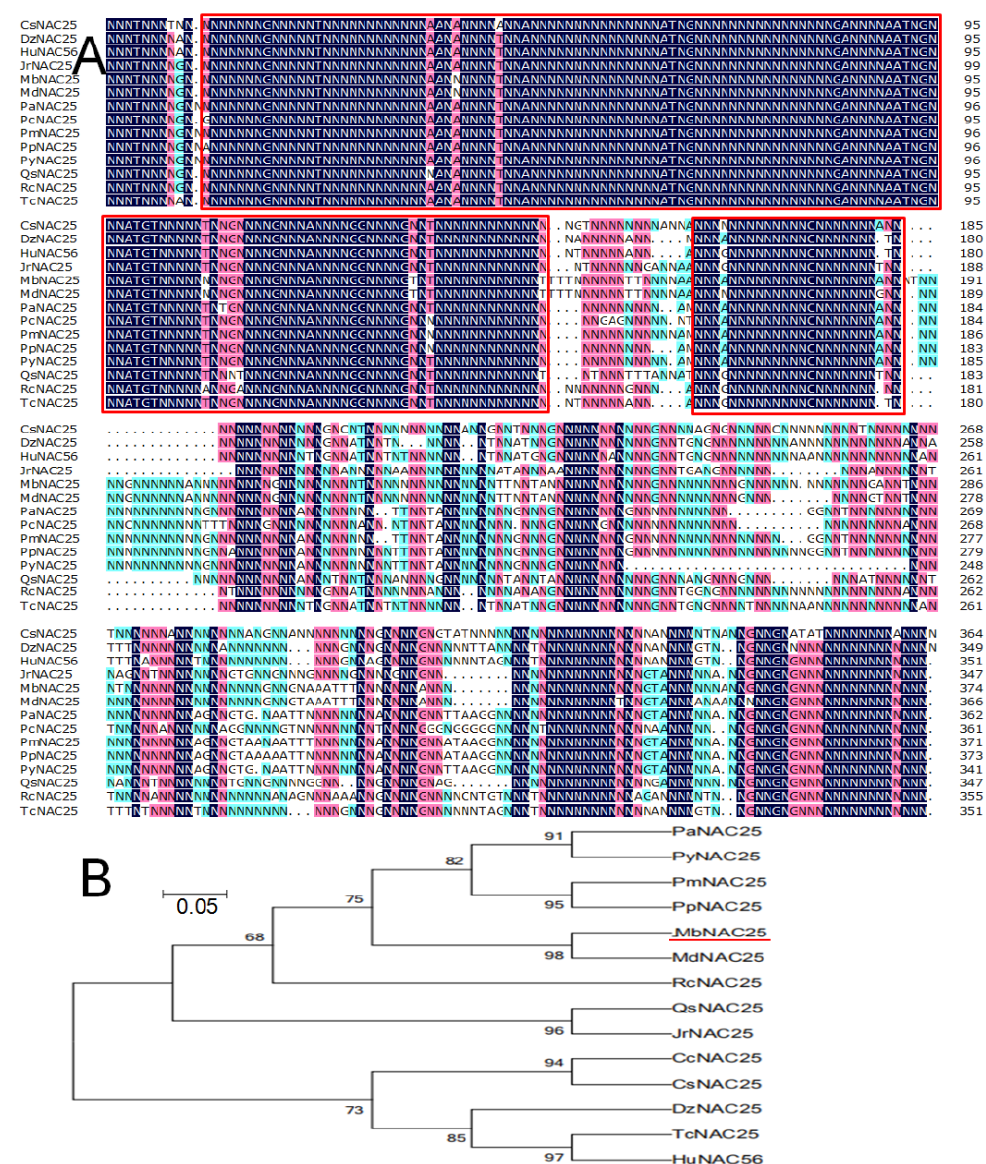
Figure 1. Comparison and phylogenetic relationship of MbNAC25 with other plant NAC25 transcription factors. ( A ). Homologous comparison of MbNAC25 protein with NAC25 proteins from other plant species. The sequence in the red frame is the conserved amino acid sequence. ( B ).